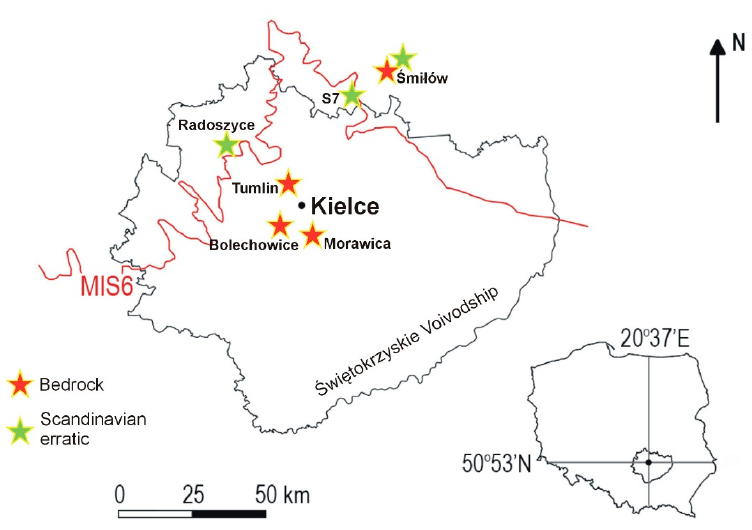
Figure 4. A simplified map of the Kielce region. Sites of specimen collection and the ice-sheet extent during the Odranian Middle-Polish Glaciation MIS (marine isotope stage) 6 according to [2] are marked.